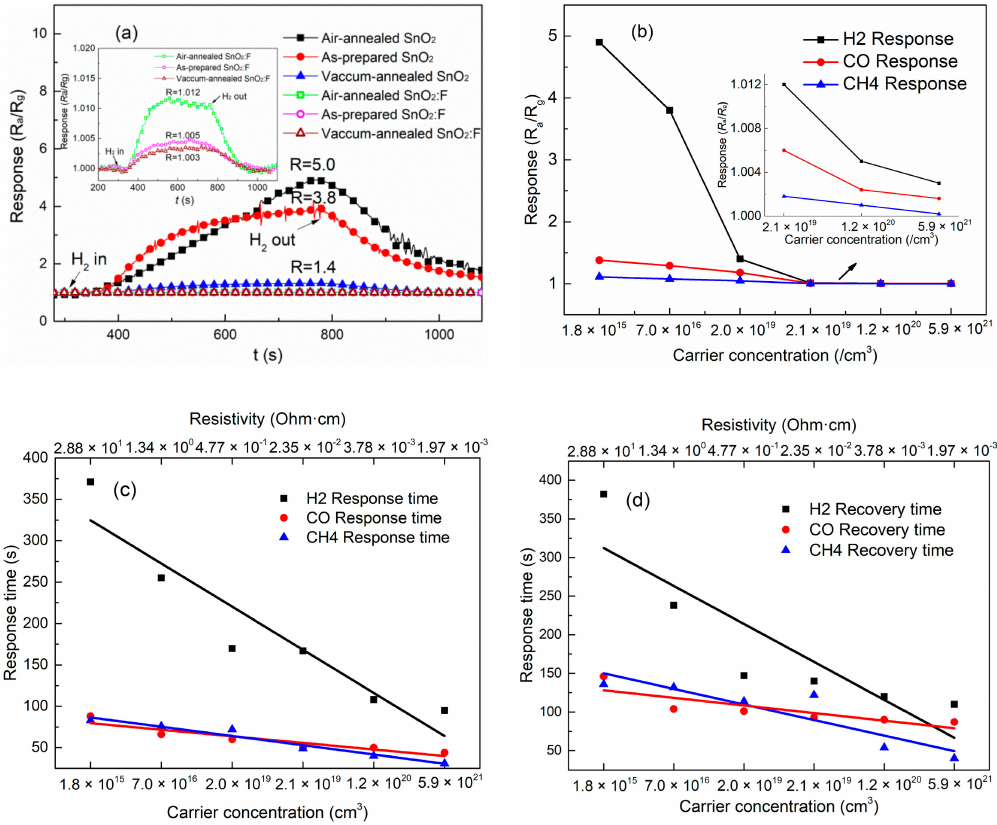
Figure 5. ( a ) H 2 response of di ff erent SnO 2 -based films, ( b ) dependence of the H 2 , CO and CH 4 response of films on carrier concentration, and dependence of the H 2 , CO and CH 4 response time ( c ) and recovery time ( d ) of films on carrier